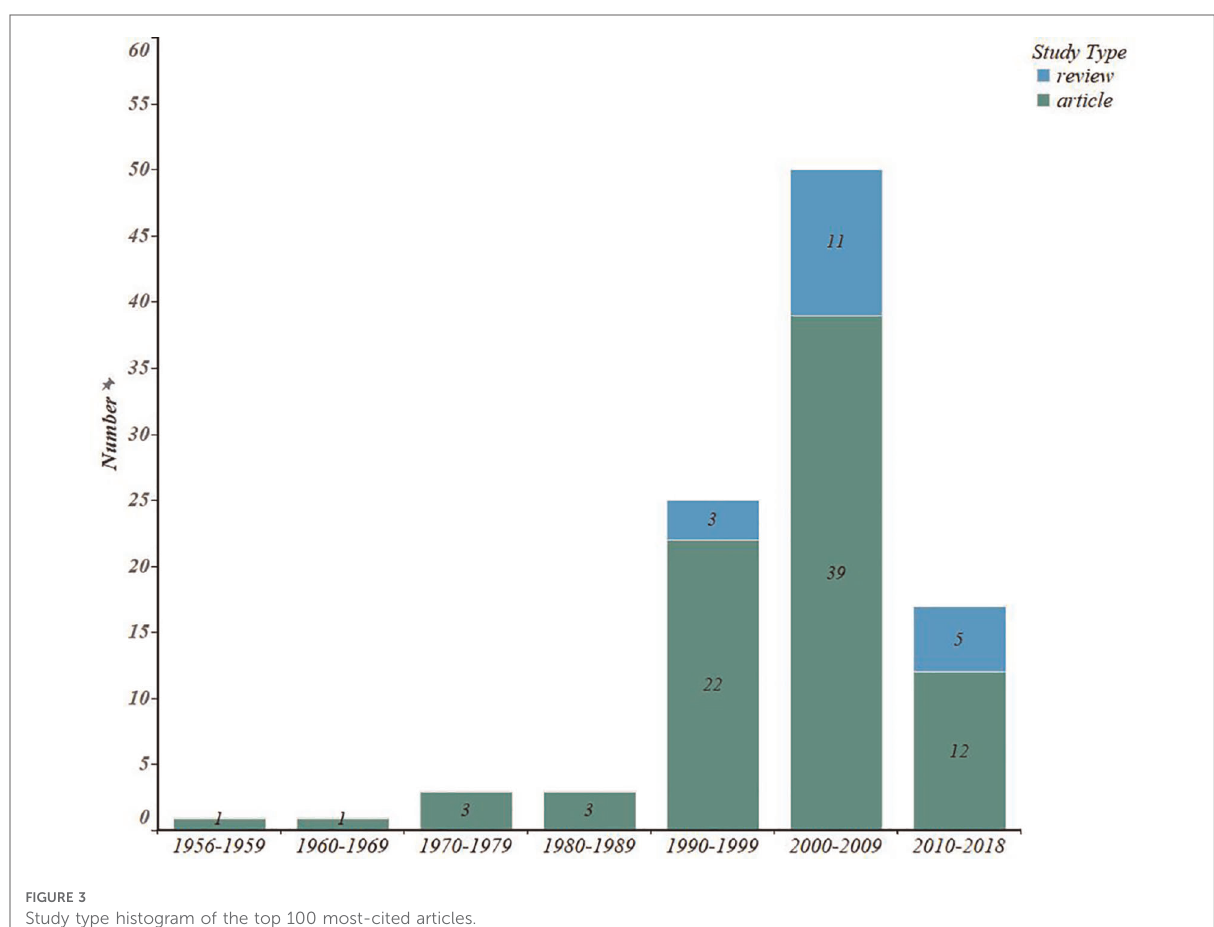
FIGURE 3 Study type histogram of the top 100 most-cited articles.